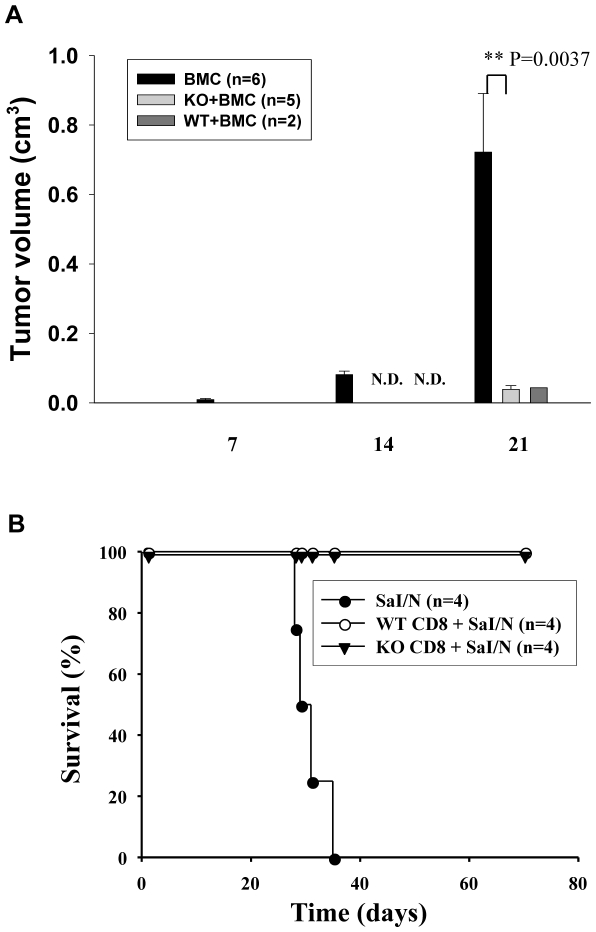
CD103 is not required for effective clearance of solid tumor by donor CD8 T cells.A. Lethally irradiated A/J mice were inoculated with SaI/N fibrosarcoma (H-2a) plus BALB/c-WT (WT) either alone (BMC only, n = 6) or in combination with purified CD8 T cells from primed WT (n = 8) or BALB/c-CD103 KO donors (n = 8). Data shown are the mean volumes of solid tumor (cm3) measured at the indicated time points ± SEM. N.D. indicates that no tumor was detected. This is a combination of two separate experiments with similar results. Since some experimental mice died early of GVHD, data of 6, 5 or 2 recipient mice of each respective group are shown in last time point. B. Sal/N fibrosarcoma cells (1.0×106) were transferred into BALB.scid mice alone (closed circles; n = 4) or together with primed CD8 T cells (1.0×107) from either WT (triangles; n = 4) or KO donors (open circles; n = 4). Data show mortality of recipient mice. Surviving mice were sacrificed at day 70 after adoptive transfer.